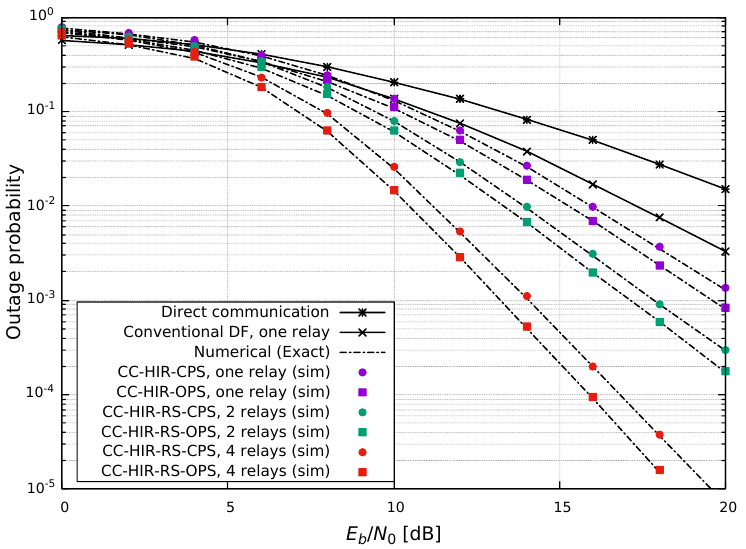
Figure 4. Numerical and simulated outage probability results versus SNR per information bit E b / N 0 at the destination of the CC-HIR-RS-CPS ( ρ r = 0.5 for all relays) and CC-HIR-RS-OPS schemes for different number of relays, direct communication, and one relay communication applying conventional DF strategy for R = 0.5